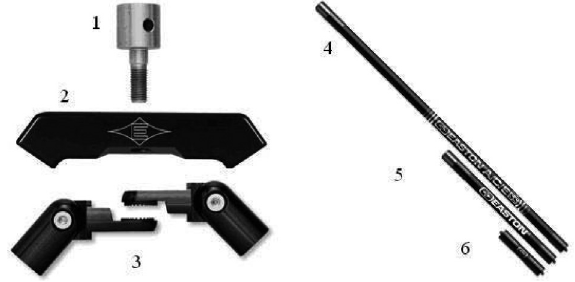
Fig. A1. Stabilizer System: 1 – fastening bolt; 2 – uni-bar; 3 – side-rod adjustable members; 4 – central rod; 5 – side rod; 6 – extender